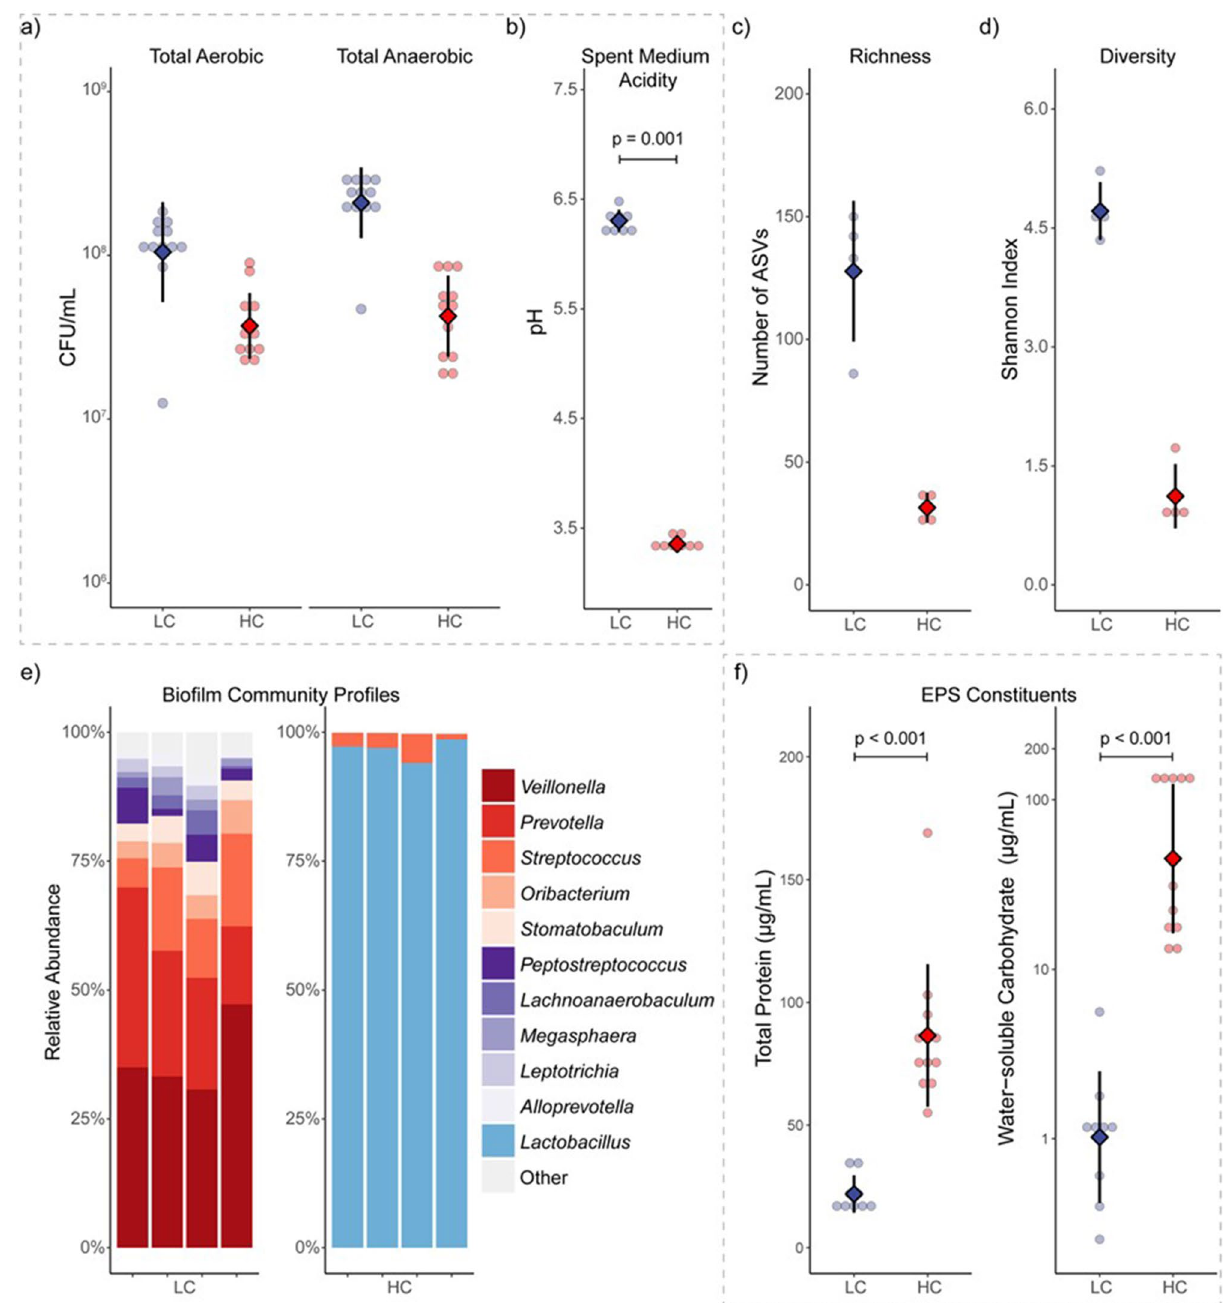
Figure 1. Characterisation of the biofilms grown using basic (LC, blue) or enriched (HC, red) growth medium diet (n = 3). ( a ) Showing the number of total viable bacteria after 5 days of incubation in 5% CO 2 air, and ( b ) spent medium pH of the LC and HC groups. ( c ) Community richness and ( d ) diversity of the respective biofilms, and ( e ) genus level taxonomic profiles showing genera with ≥ 1% relative abundance. ( f )